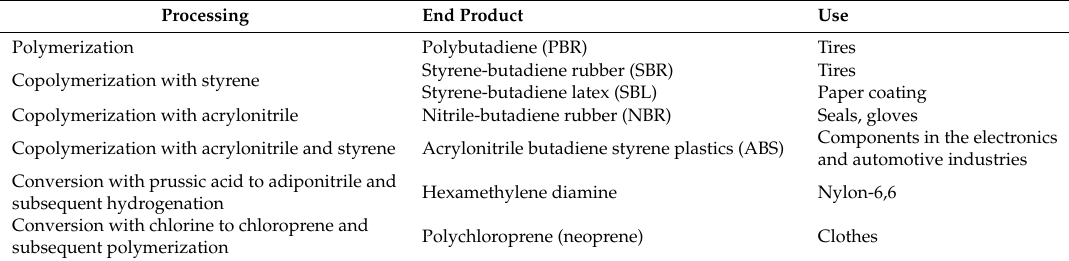
Table A1. Processing of 1,3-butadiene, its end products, and their use [4].